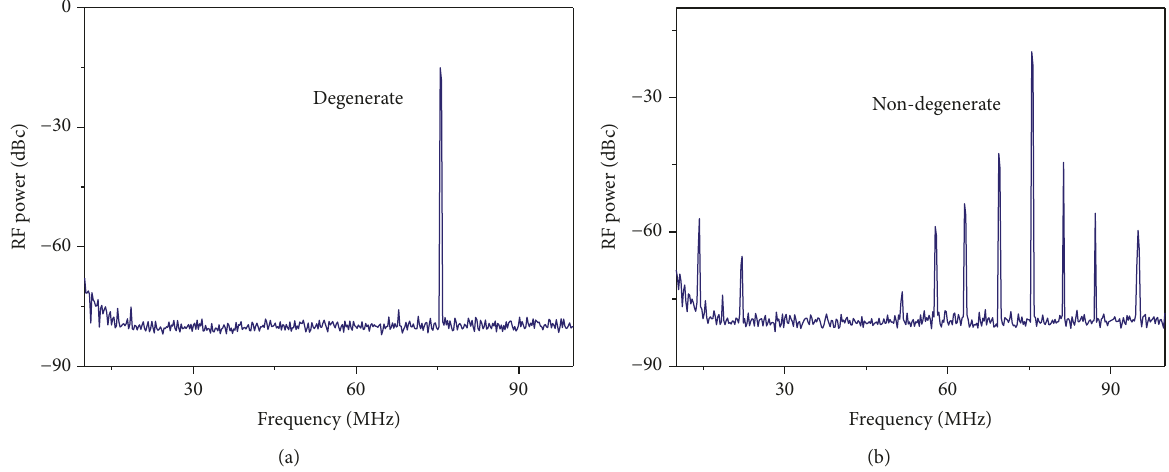
Figure 4: RF spectra of the degenerate and near-degenerate OPO with resolution bandwidth of 10kHz,